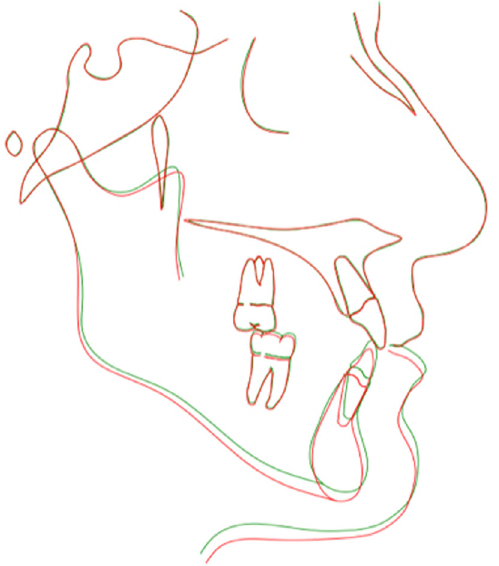
Figure 15. Cephalometric superimposition on sella: Posttreatment (red line) and one-year follow-up (green